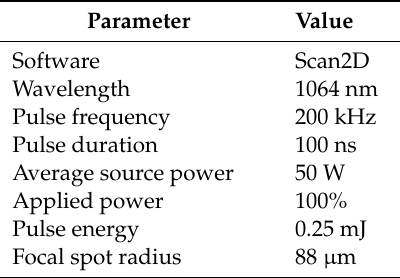
Table 2. Laser parameters for surface structuring of cemented